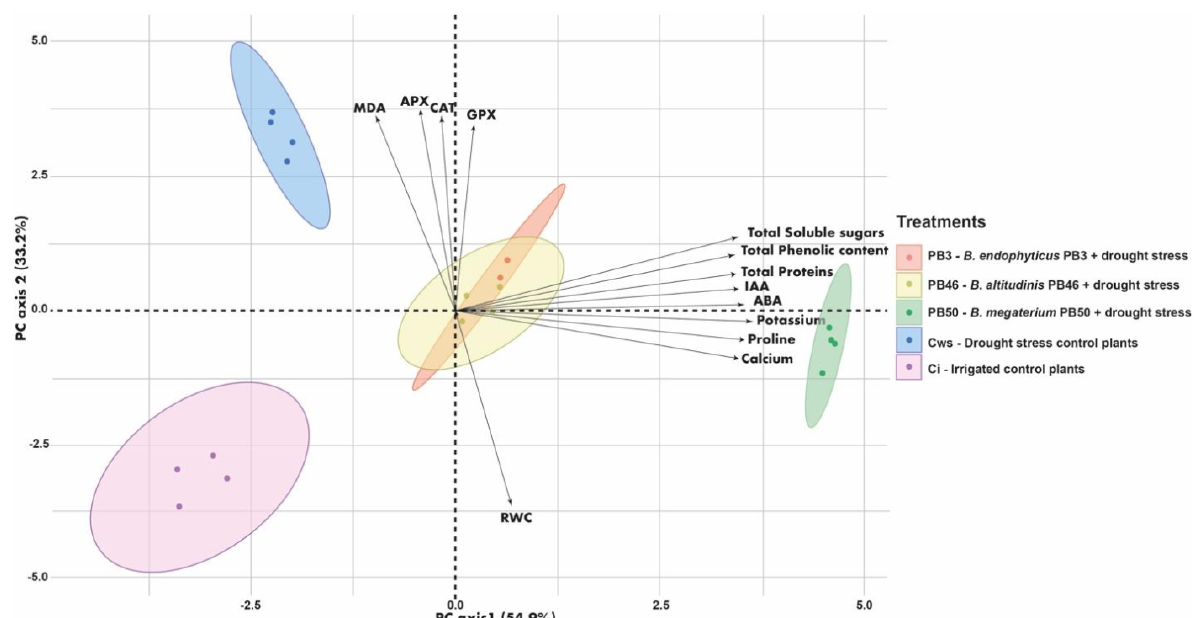
Figure 1. Plot of principal component analysis (PCA) showing ordination of the samples based on the physiochemical and biochemical properties of the plant leaves. Treatment are indicated by 95% confidence ellipses. RWC, relative water content; APX, ascorbate peroxidase activity; CAT, catalase activity; GPX, glutathione peroxidase activity; MDA, malondialdehyde; IAA, indole acetic acid; ABA, abscisic